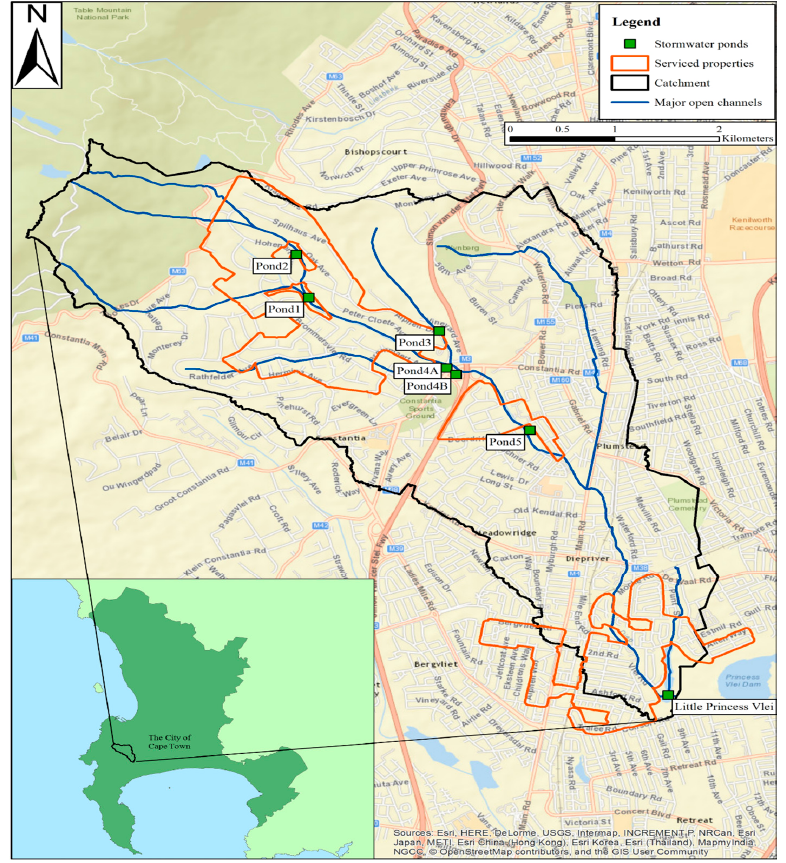
Figure 1. The Diep River sub-catchment and outline of properties that are serviced by the SWH scenarios (After ESRI et al. [24]).